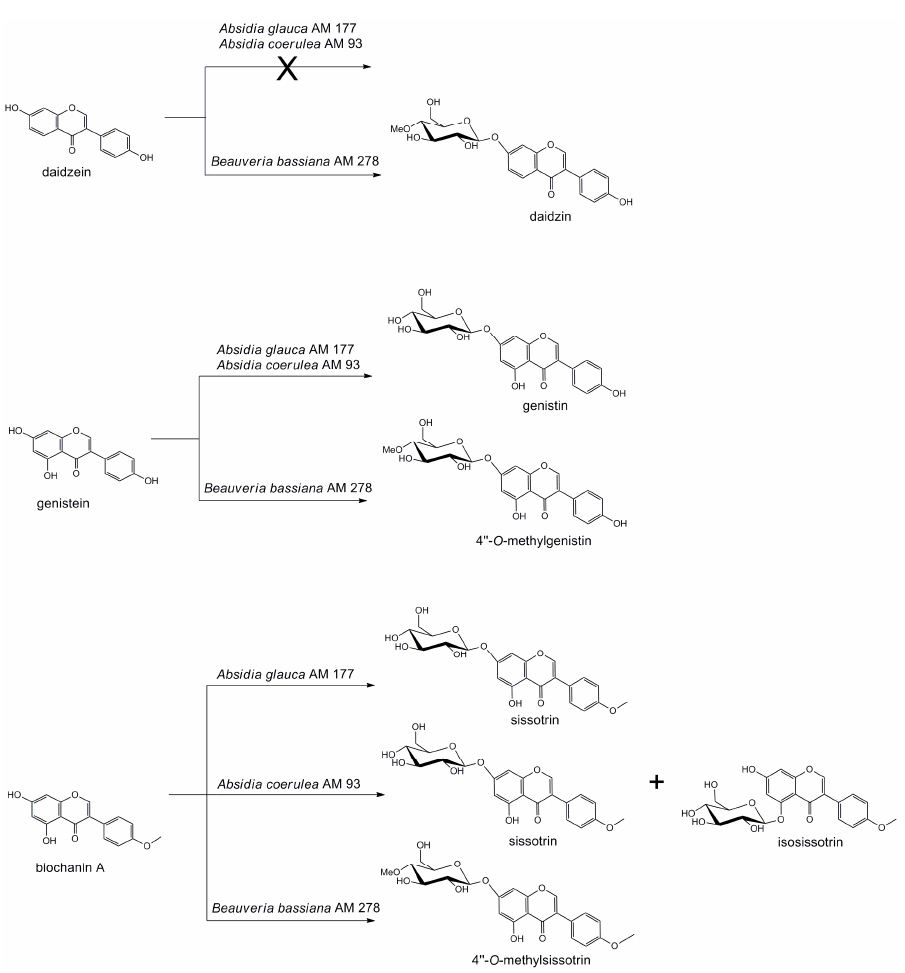
Figure 1. Transformation of isoflavonoids by selected fungi.